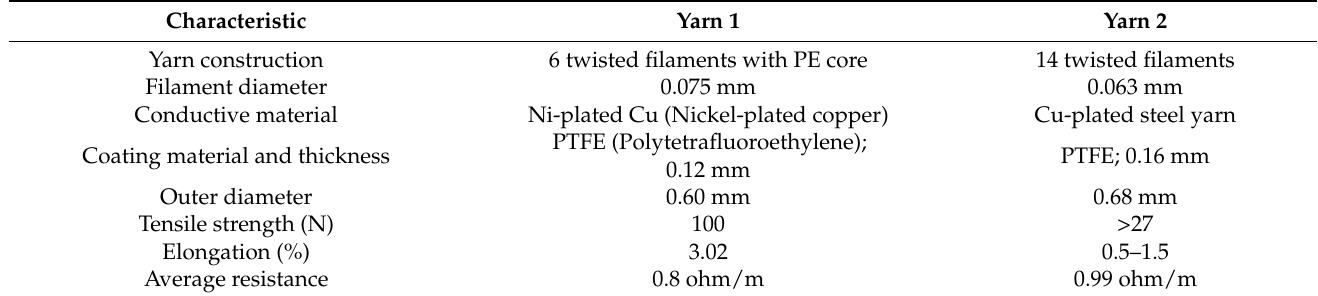
Table 1. Overview of conductive yarns used in